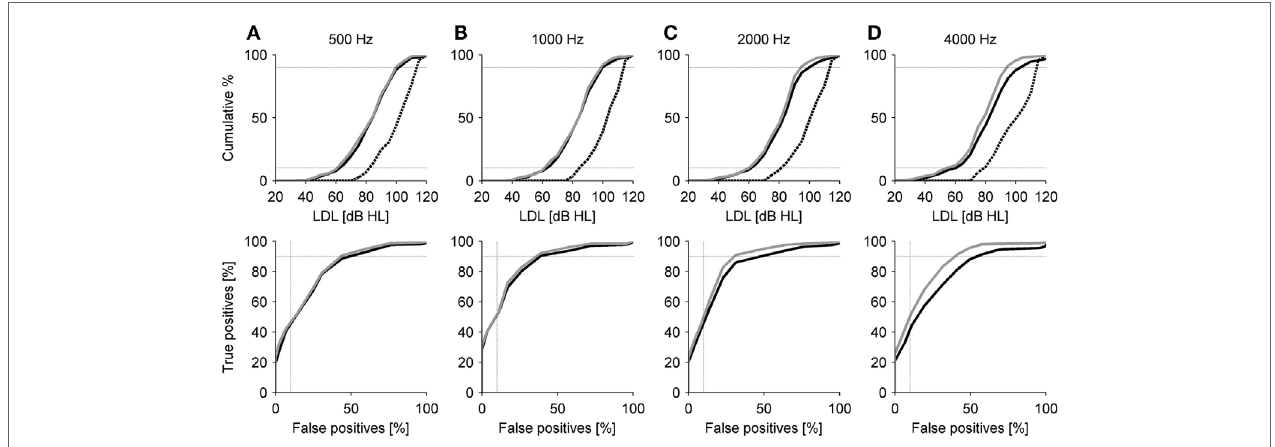
and Methods). Black solid lines – all patients compared to reference group; gray solid lines – patients with normal hearing thresholds compared to reference group. Dotted lines indicate 90% true positives and 10% false positives. Panels (a – D) show the data for 500, 1000, 2000, and 4000 Hz,